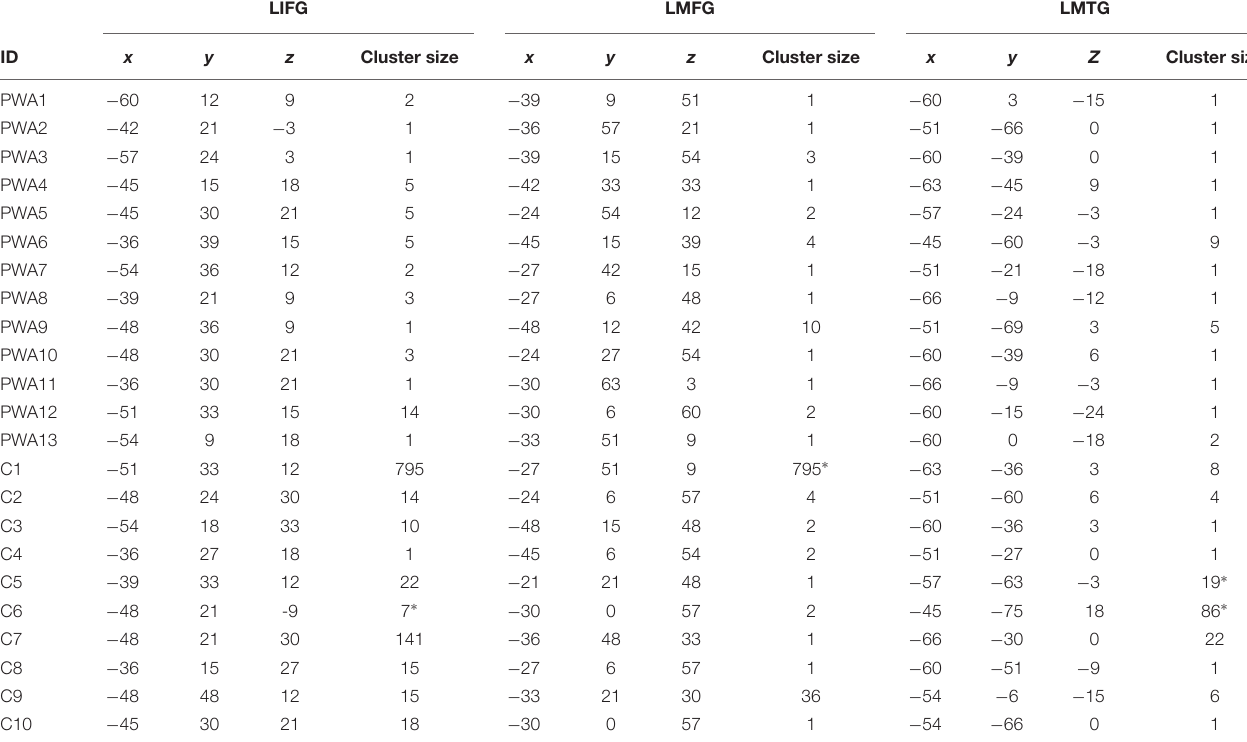
The ∗ reflects the size of a cluster for which the peak maxima of the cluster is in a different anatomical region. VOIs were created with the peak maxima that fell within the anatomical boundaries of the regions of interest.